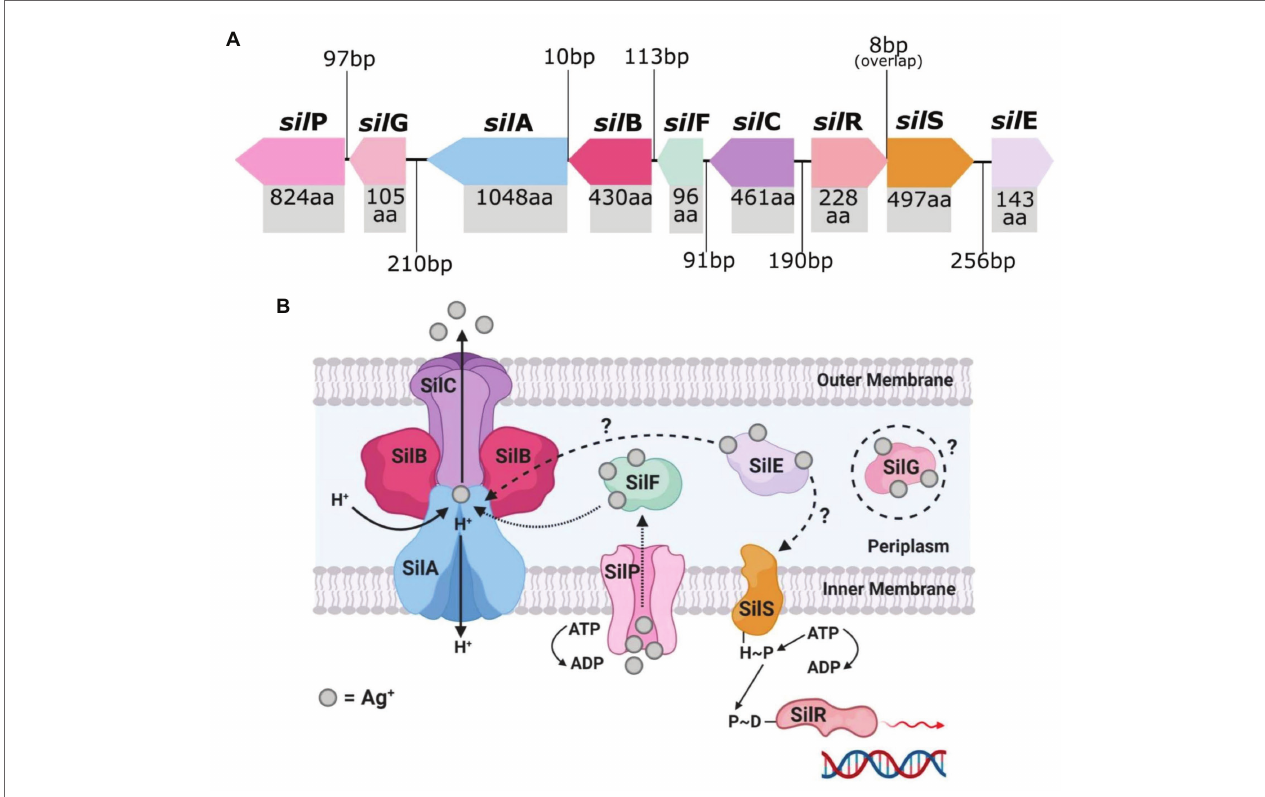
FIGURE 3 | The top image (A) shows the genetic arrangement of the sil operon and includes the intergenic DNA base pair (bp) gaps/overlaps and each sil gene’s protein product amino acid (aa) length. The bottom image (B) is a graphical representation of the known and predicted protein arrangement and functions of the encoded membrane bound Sil efflux system. Created in Inkscape (A) and BioRender (B) . Adapted from Randall et al.